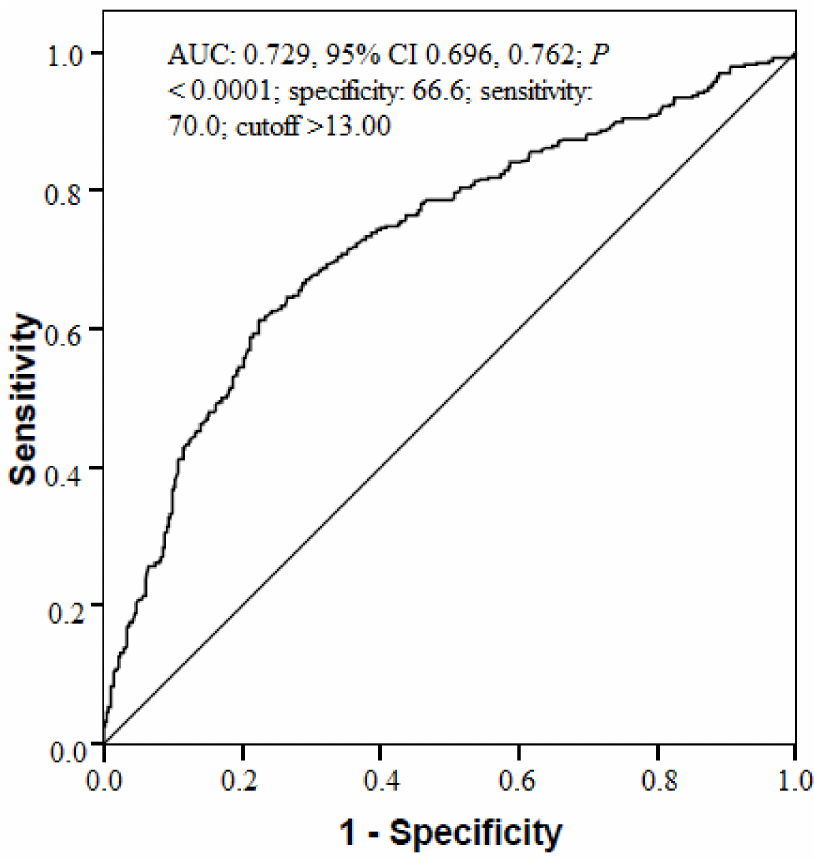
Figure 3. MHR receiver-operating characteristic (ROC) analysis between smokers and non-smokers. AUC, area under the curve; CI, confidence interval; MHR, Monocyte to HDL-C ratio; ROC, receiver operating